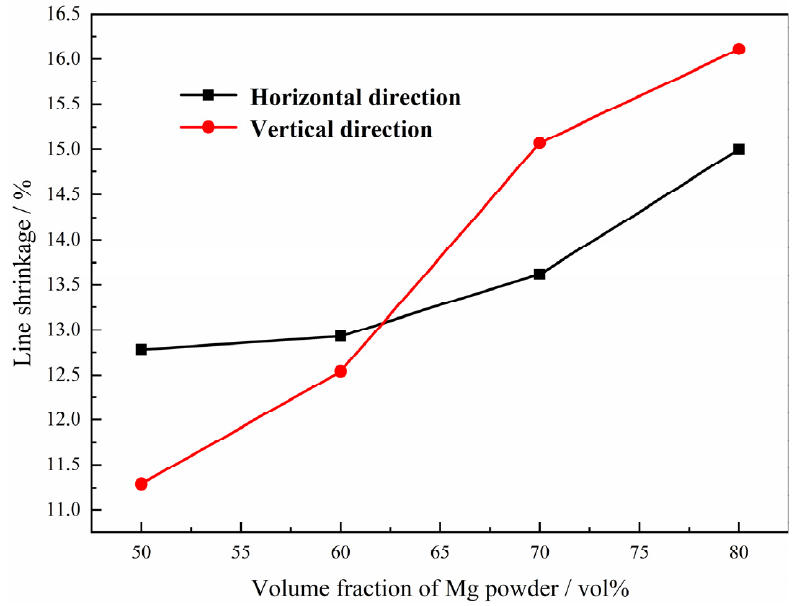
Figure 7. Relationship between line shrinkage and volume fraction of magnesium powder in the green compact after sintering.